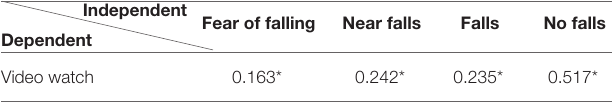
TABLE 7 | Statistical analysis in both groups using t -test (R s ).